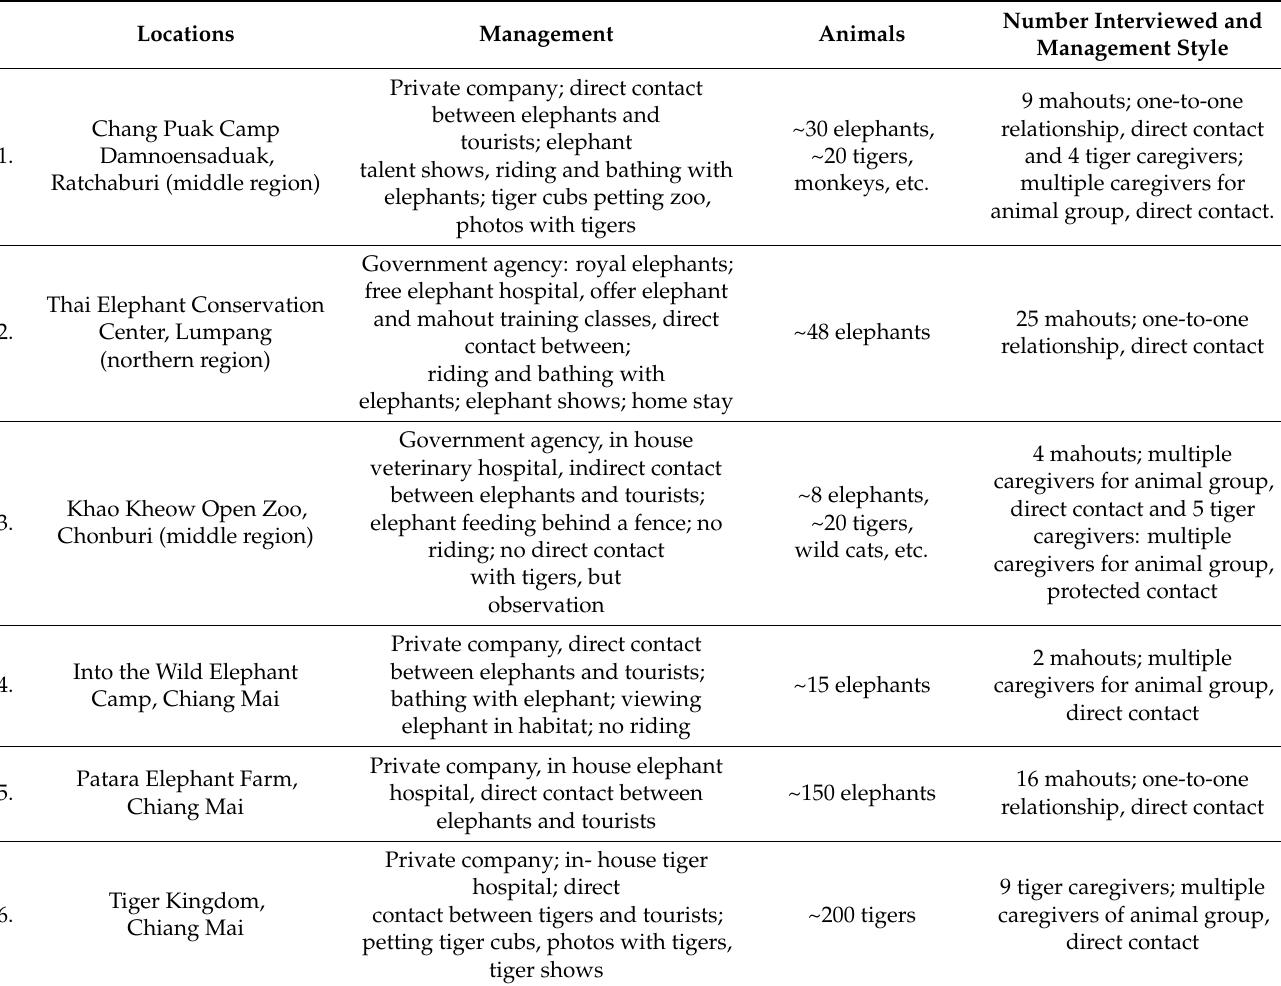
Table 1. Characteristics of tourism facilities, animal species, and styles of animal